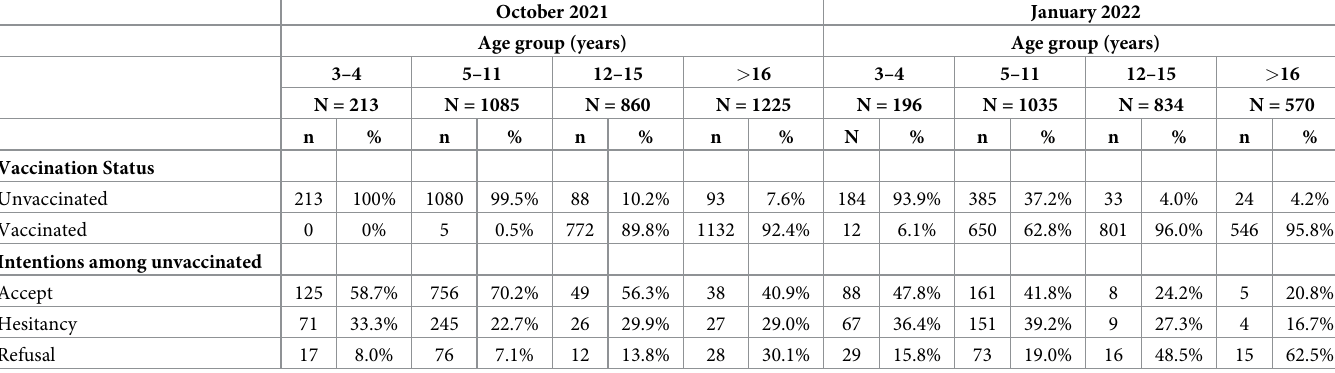
Table 2. Vaccination against SARS-CoV-2 and intentions among unvaccinated students over 16 years and parents of unvaccinated students under 16 years at SSNC, Catalonia, Spain. October 2021 and January